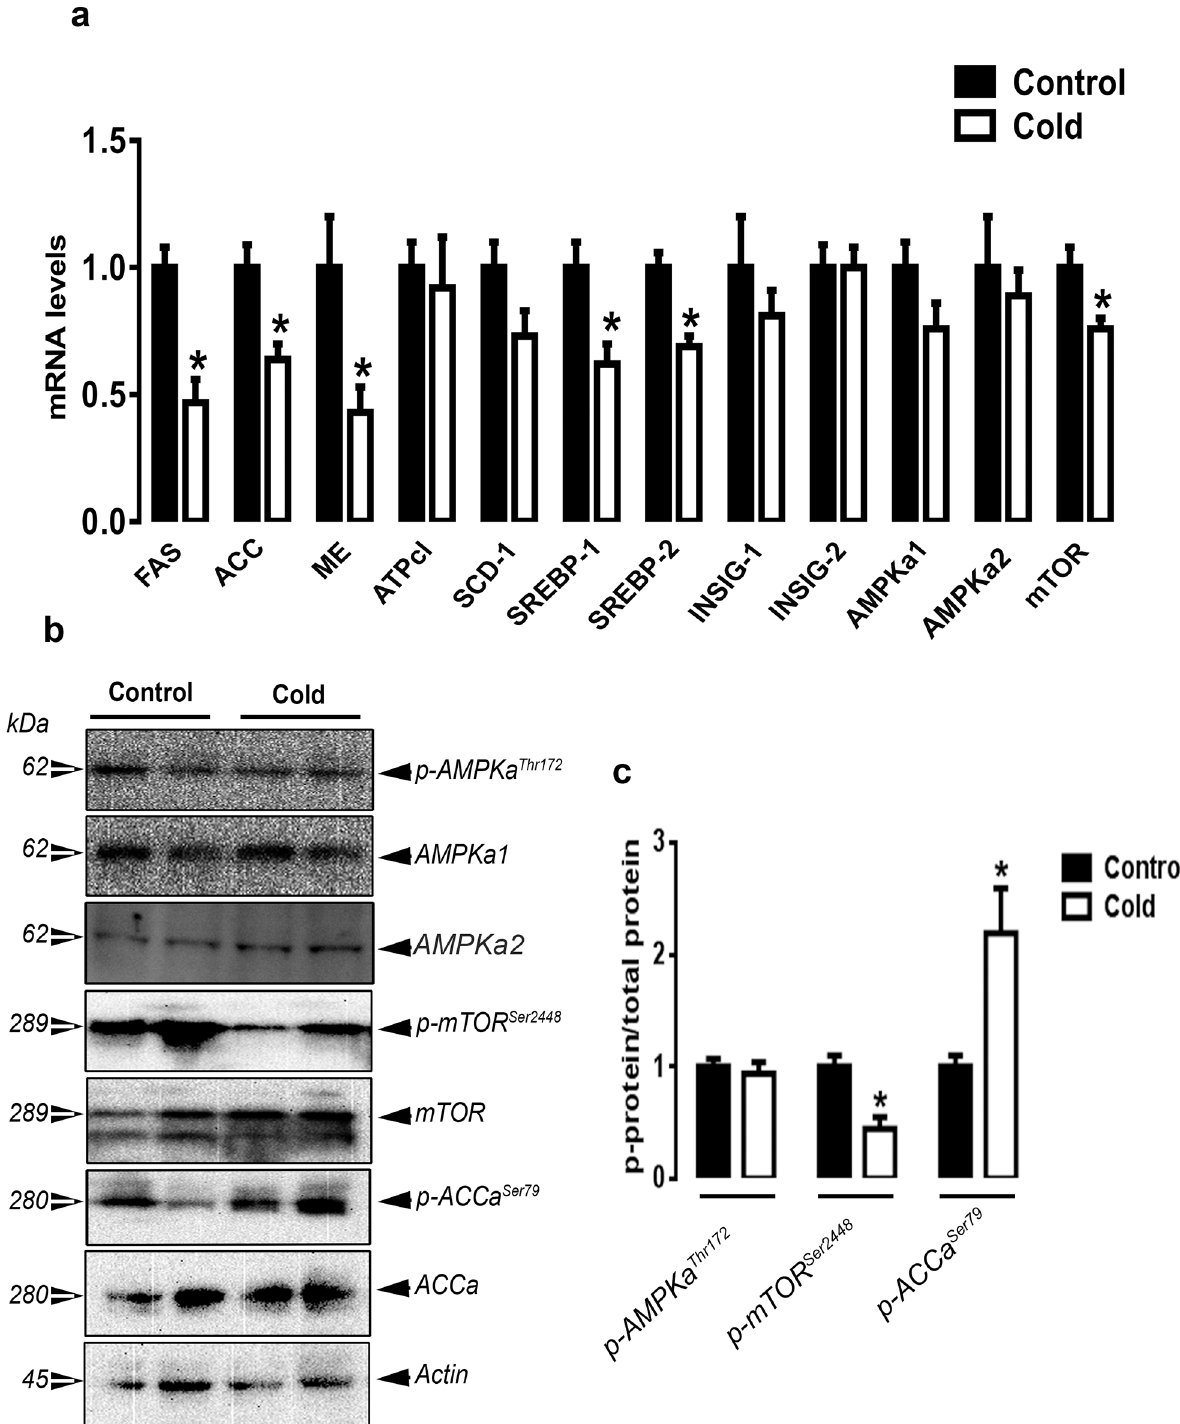
Fig 4. Effect of CMCC on lipogenesis-related genes in liver of young broiler chicks. Relative expression of lipogenic genes and their related transcription factors (a) was measured by qPCR as described in material and methods. Phosphorylated and total protein levels of AMPK, mTOR and ACC were determined by Western blot (b) and presented as p-protein/total protein ratio (c). β -actin was used as loading and housekeeping control. Data are presented as mean ± SEM (n = 6). * Indicate a significant difference between cold and control group ( P < 0.05).